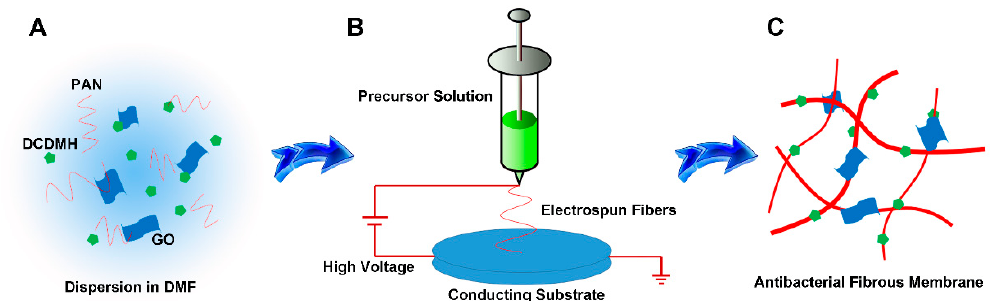
Figure 1. Schematic illustrating the synthesis of PAN/GO/DCDMH fibrous membrane using electrospinning: ( A ) dispersion of PAN, DCDMH, and GO in DMF; ( B ) electrospinning process; and ( C ) diagrammatic sketch of the PAN/GO/DCDMH nanostructures.